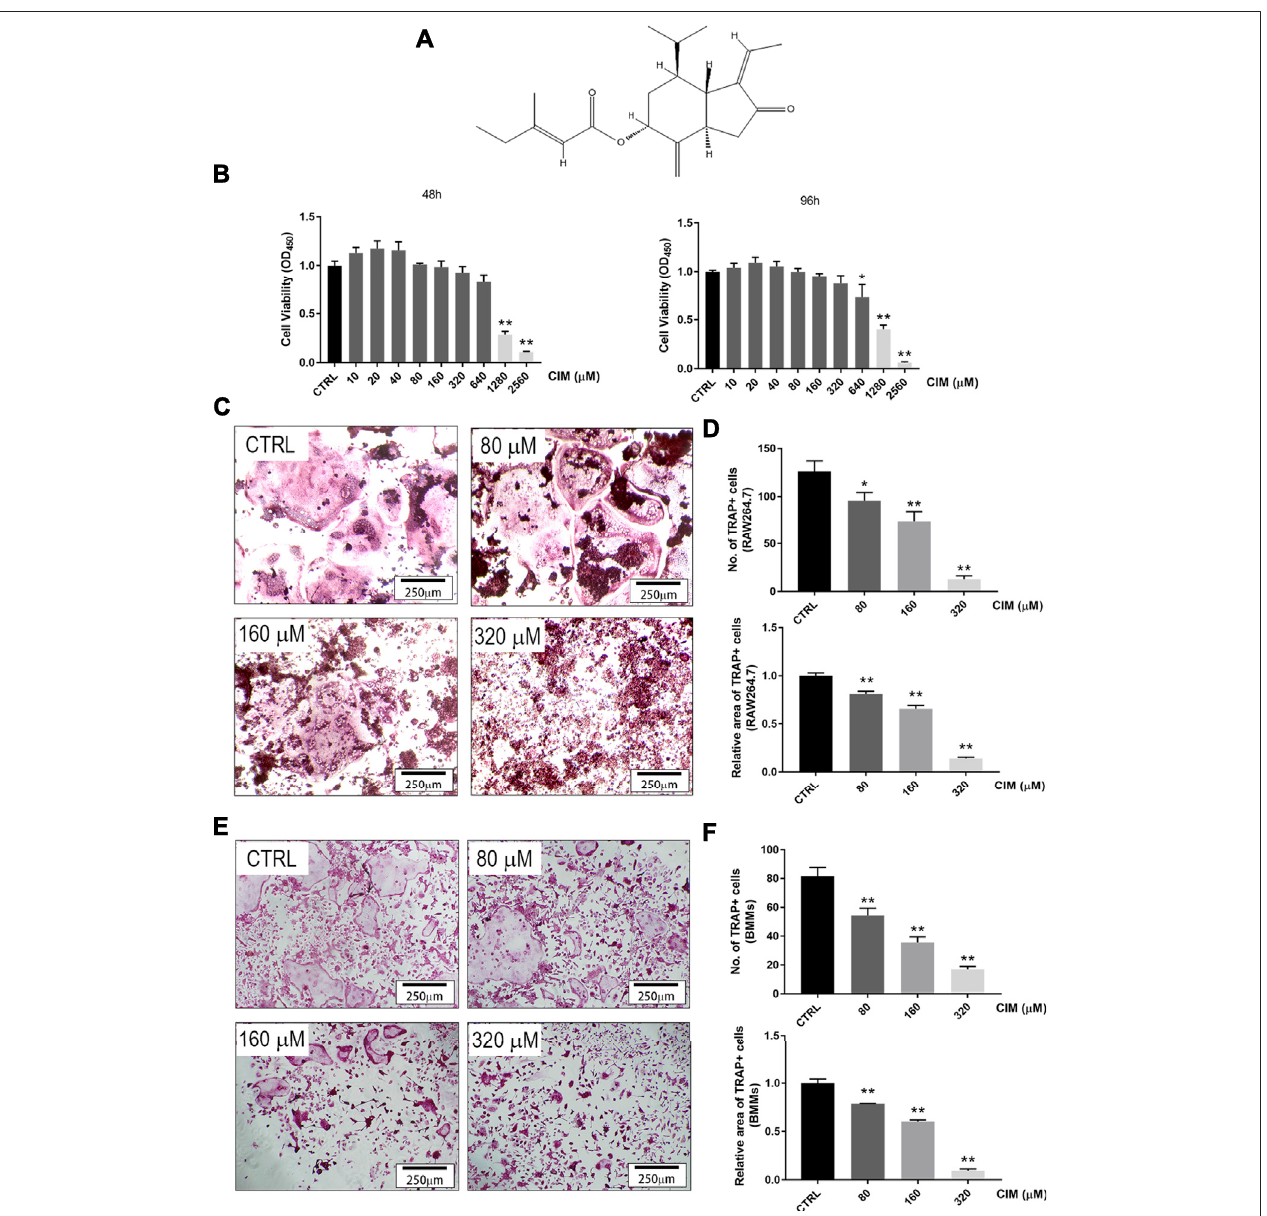
FIGURE 1 | CIM at a noncytotoxic dose inhibits RANKL-induced osteoclast formation in RAW264.7 and BMM cell lineages in a dose-dependent manner. (A) The chemical structure of CIM. (B) The cell viability of BMMs treated with CIM at different doses for 48 or 96 h. CIM at doses less than or equal to 320 μ M was identi fi ed as noncytotoxic. (C) and(E) TRAPstainingimages ofRAW264.7cellsand BMMsincubated withCIMat gradient concentrationsfor5 – 7 days.Thenumbers (D) and areas (F) of TRAP + osteoclasts were quanti fi ed and analyzed. (*: p < 0.05; **: p < 0.01 compared with the control group).